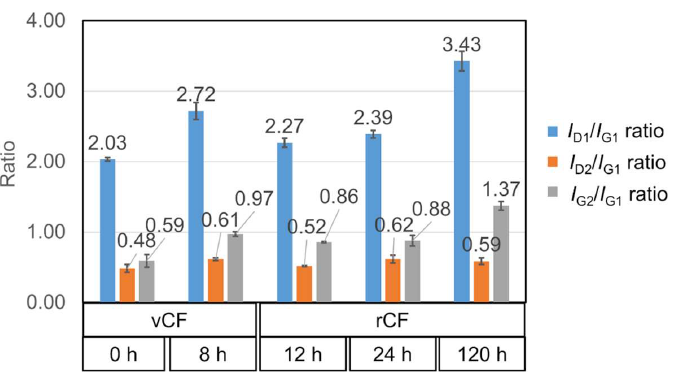
Figure 9. I D1 / I G1 ratio, I D2 / I G1 ratio, and I G2 / I G1 ratio of vCF and rCF obtained from Raman spectros- copy